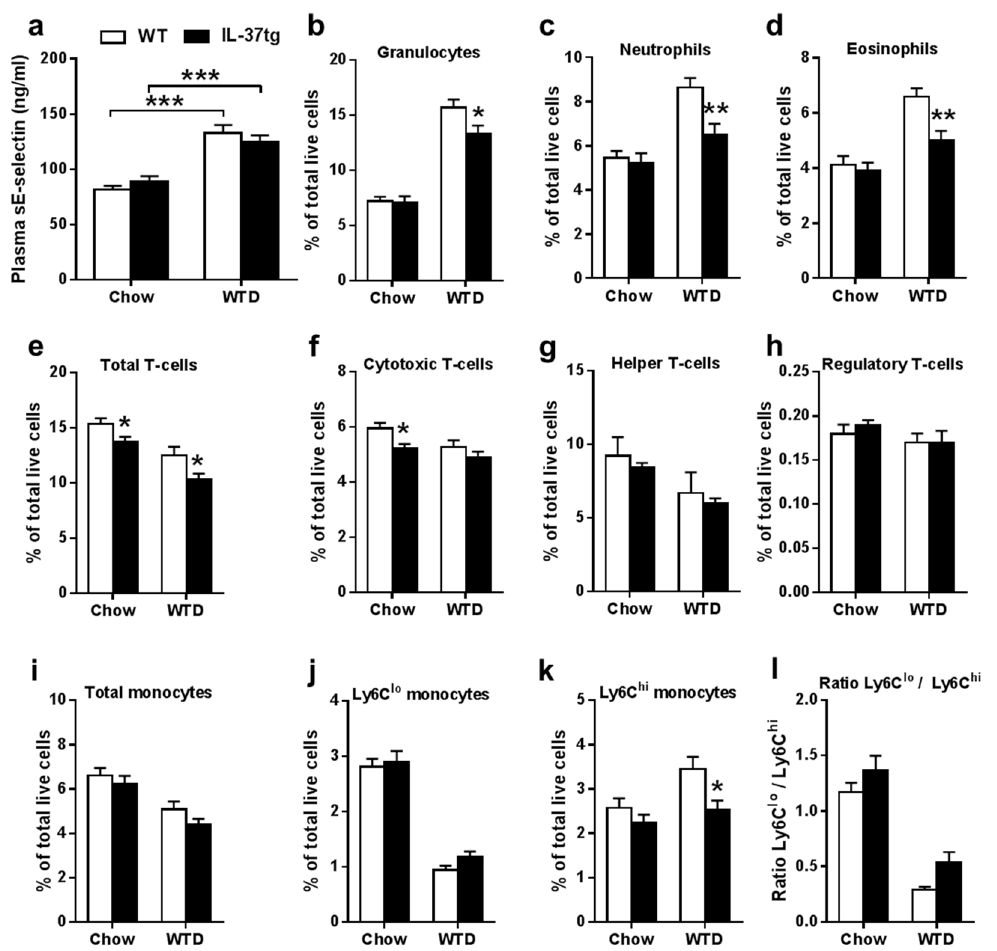
Figure 2. Expression of IL-37 in hematopoietic cells reduces circulating immune cells. Plasma soluble E-selectin (sE-selectin) levels in Ldlr − / − mice transplanted with either IL-37tg or wild-type (WT) bone marrow were determined just before Western-type diet (WTD)-feeding on regular chow diet, and after eight weeks of WTD-feeding ( a ); The indicated circulating immune cells in whole blood were determined by flow cytometry before (chow) and after three weeks of WTD-feeding (WTD) ( b – k ); Moreover, the ratio Ly6C lo /Ly6C hi was calculated ( l ); Data are expressed as means ± SEM; n = 14–15 per group; In panel 2a the effect of diet was determined using two-way ANOVA; * p < 0.05; ** p < 0.01; *** p < 0.001.